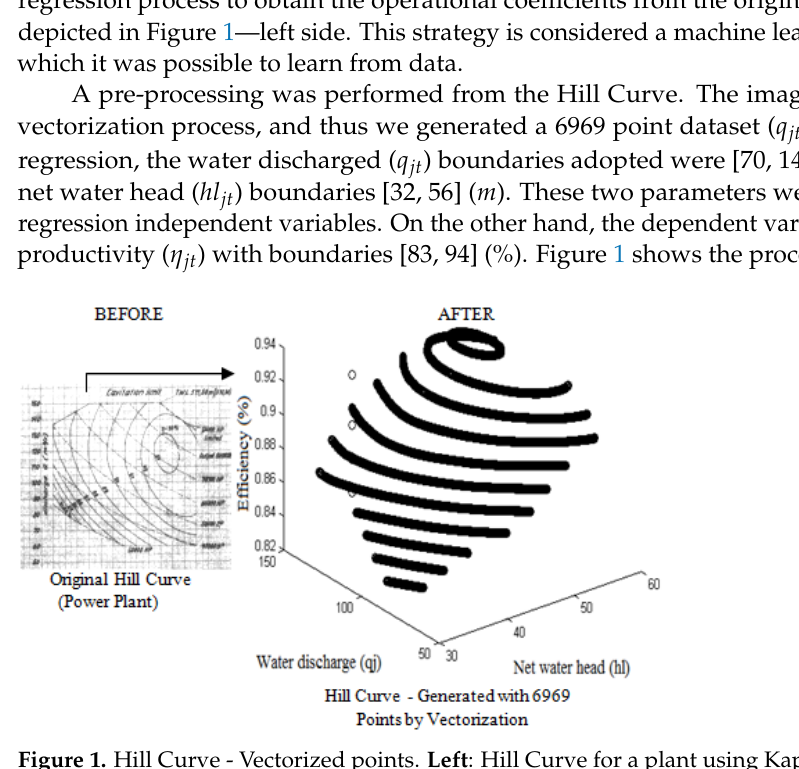
Figure 1. Hill Curve - Vectorized points. Left : Hill Curve for a plant using Kaplan and installed in 1956. Each level of productivity (efficiency) in the range [83, 94] % was redesigned and, based on a vectorization algorithm, 6969 points were generated with the information regarding ( q jt ), ( hl jt ) and ( η jt ). Right : graph plot generated using the 6969 points obtained in the